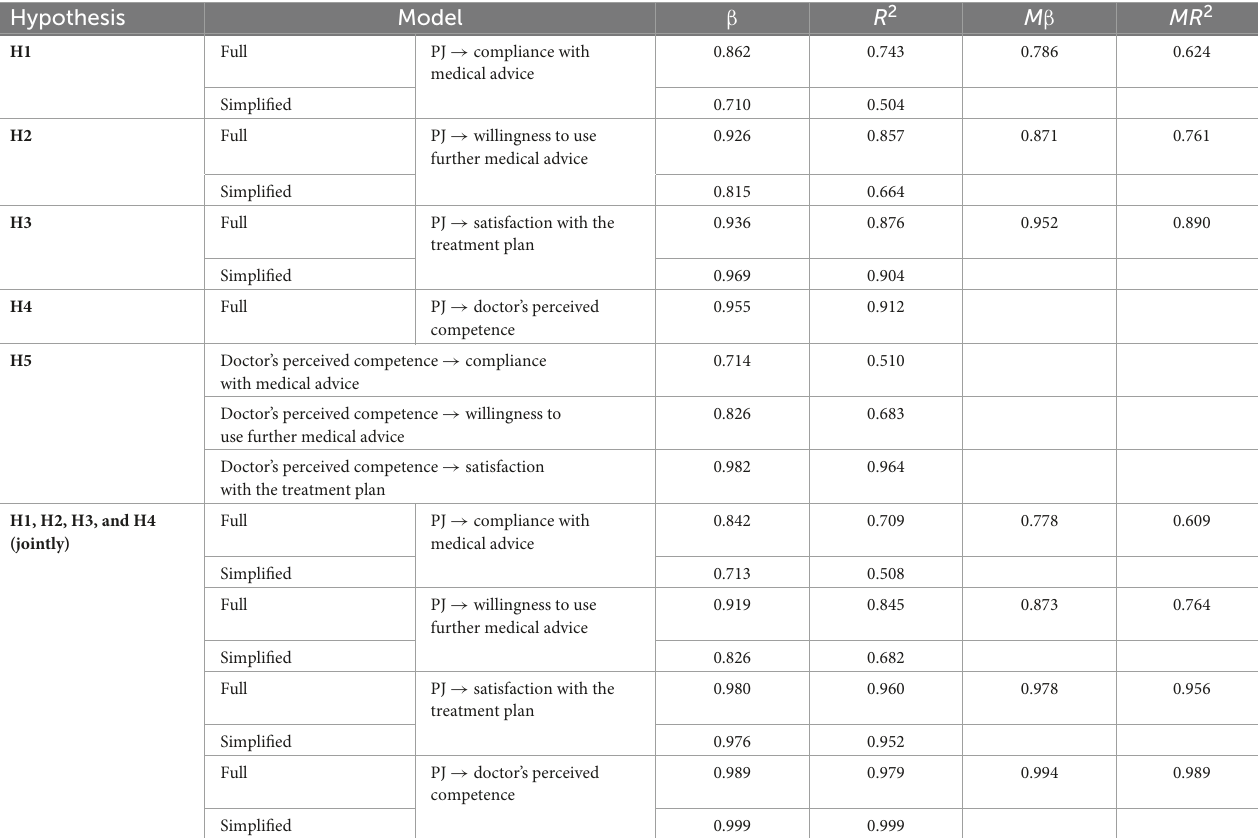
TABLE 3 Estimator values for the tested models.